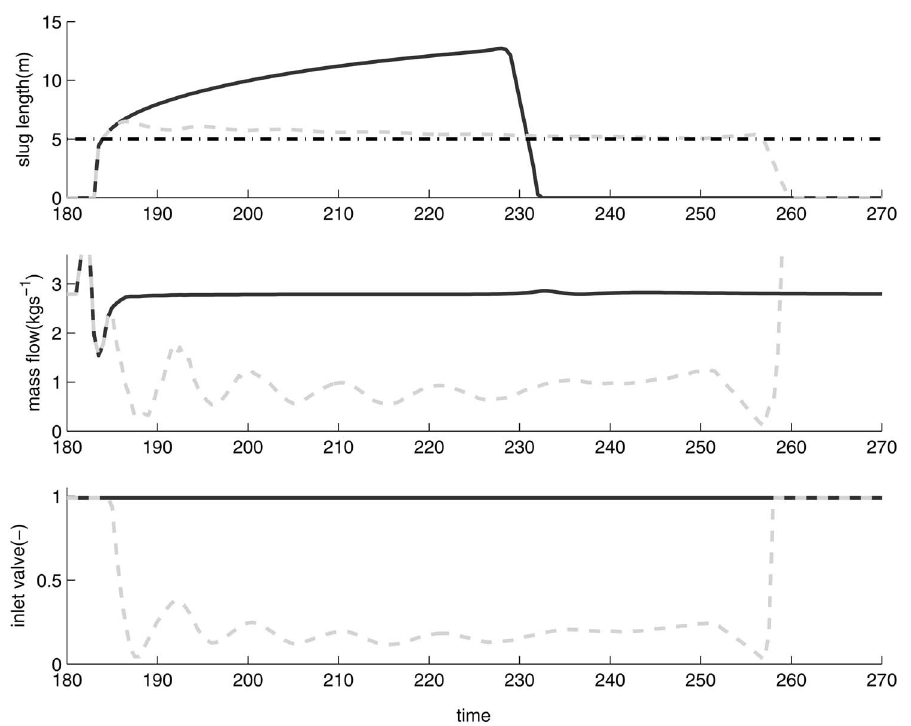
Figure 2. Active control using the inlet choke: A growing slug (solid) compared with a slug controlled by (1) (dashed) toward a reference length